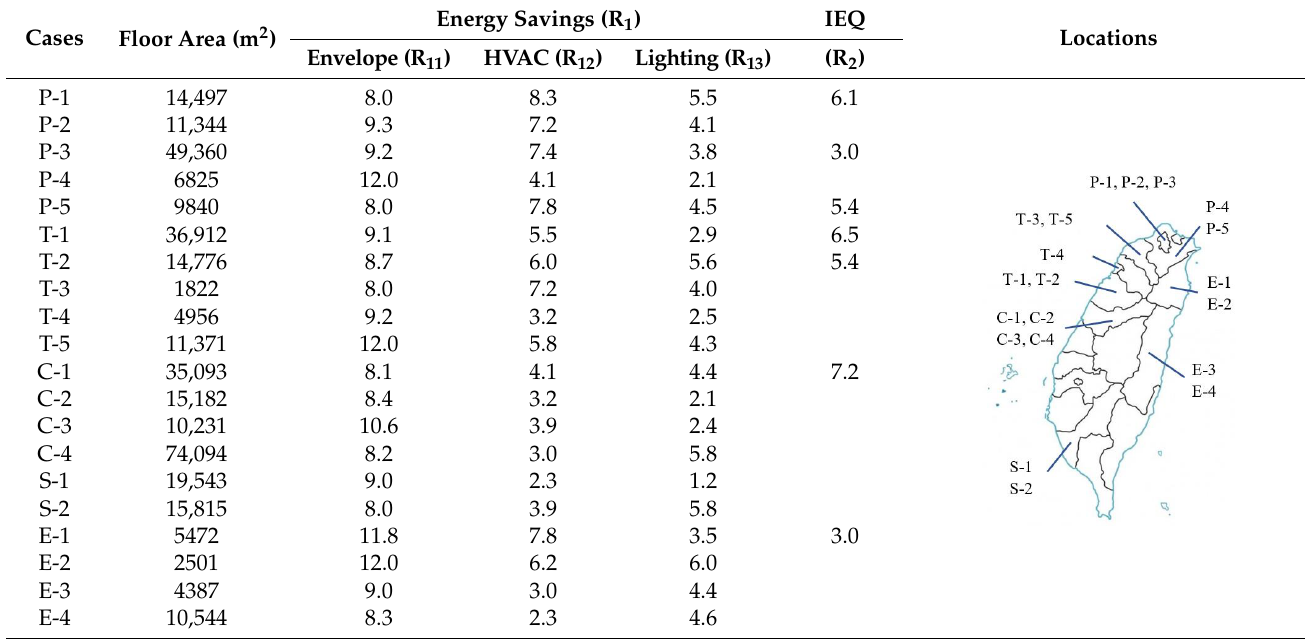
Table 2. Locations, energy savings, and IEQ scores of the investigated cases.